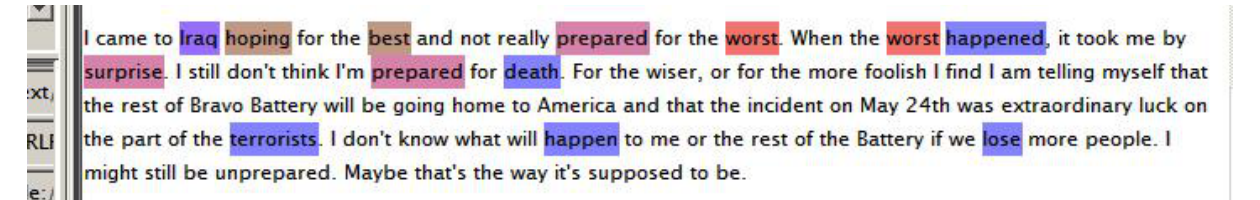
This paragraph presents an example of a specific traumatic factor: an attack against a soldier that injured innocent civilians instead. Figure 3. A section of an annotated Web blog showing physical and emotional descriptors